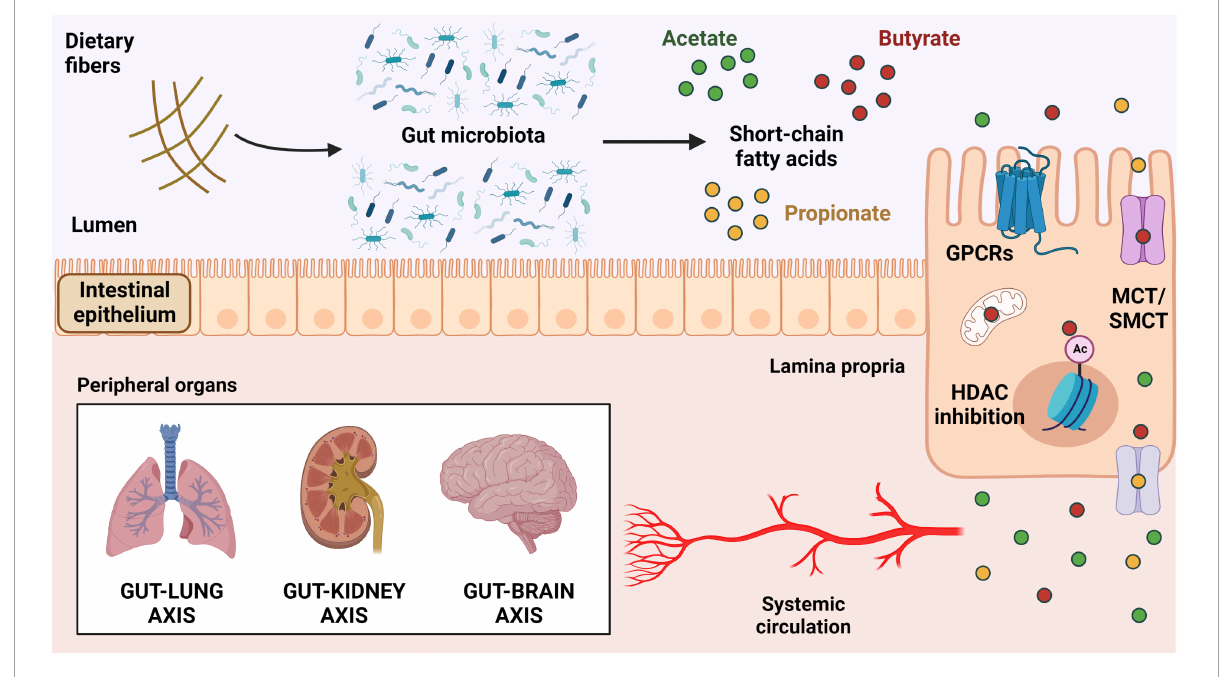
FIGURE1 Mechanisms of actions of short-chain fatty acids. Production of SCFAs by bacterial fermentation of soluble dietary fibers in the colonic lumen. These metabolites can activate GPCRs expressed on the surface of intestinal epithelial cells (HCAR2/GPR109a, FFAR2/GPR43, and FFAR3/GPR41) or be internalized by cellular transporters (MCT and SMCT). Once inside the cells, SCFAs can be used in the mitochondria for ATP generation, act in the nucleus as HDAC inhibitors, or be transported outside of the cells into the intestinal lamina propria and subsequently into the bloodstream. Upon reaching systemic circulation, SCFAs can modulate the function of several target tissues, including lungs, kidneys, and brain. SCFAs, short-chain fatty acids; GPCRs, G-protein-coupled receptors; FFAR, free fatty acids receptor; HCAR2, hydroxycarboxylic acid receptor 2; MCT, proton-coupled monocarboxylate transporter; SMCT, sodium-coupled monocarboxylate transporter; HDAC, histone